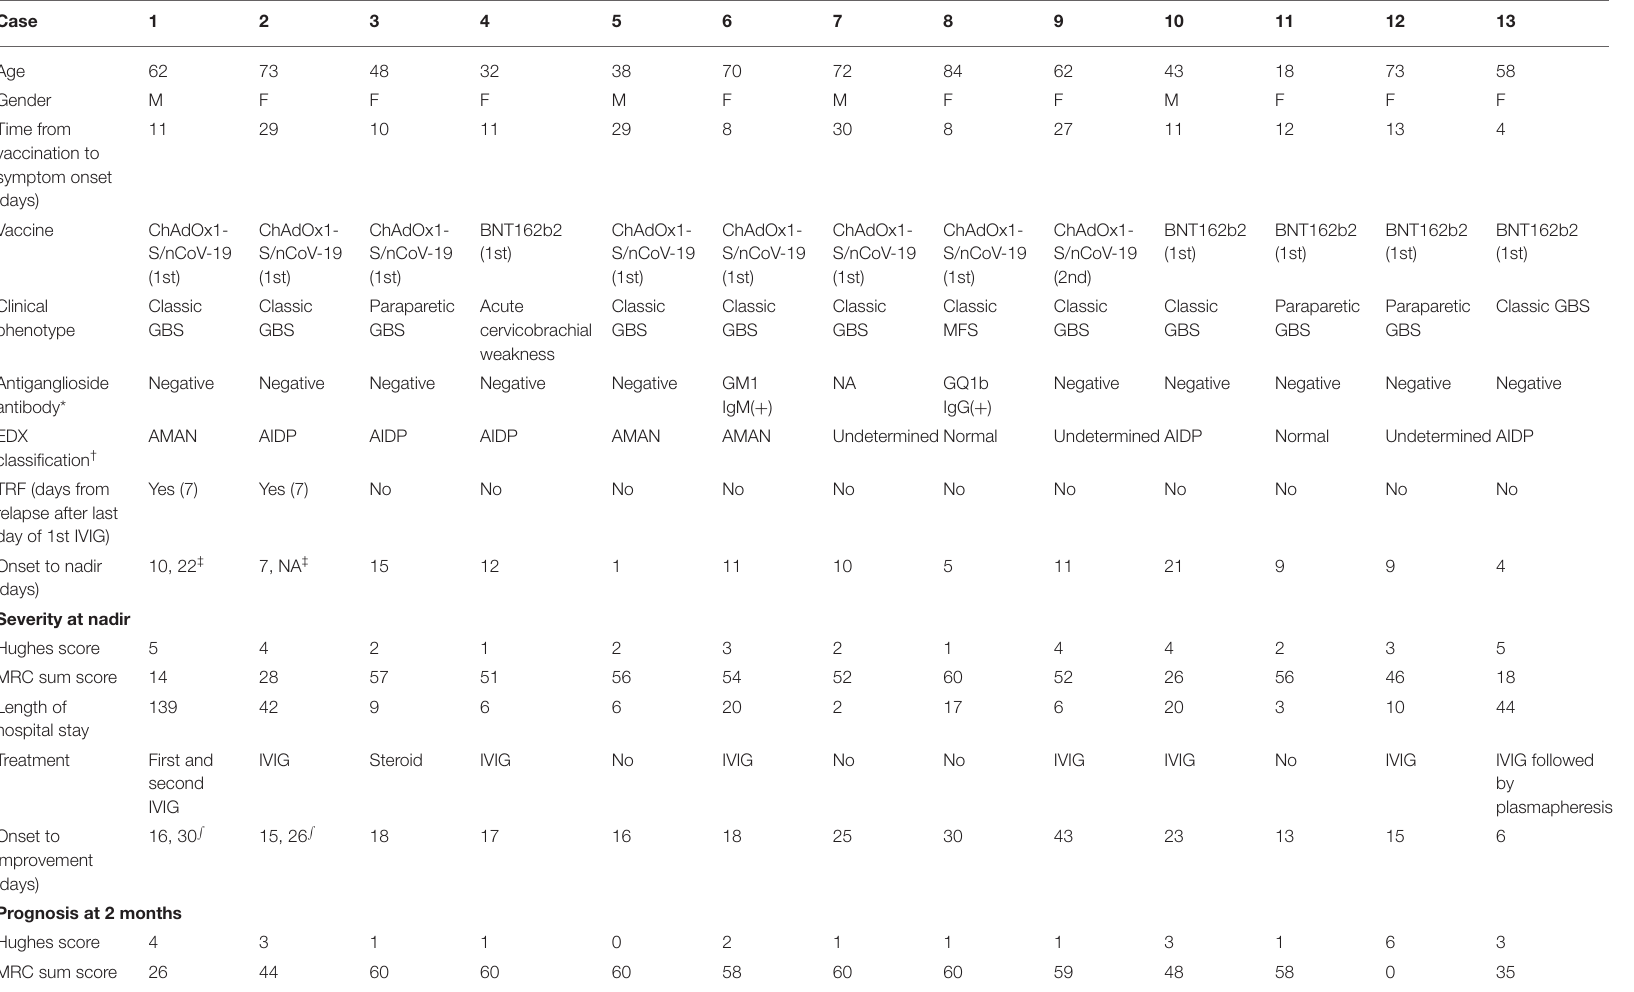
TABLE 1 | Clinical features of 13 patients with Guillain–Barré syndrome and variants post COVID-19 vaccination. Case